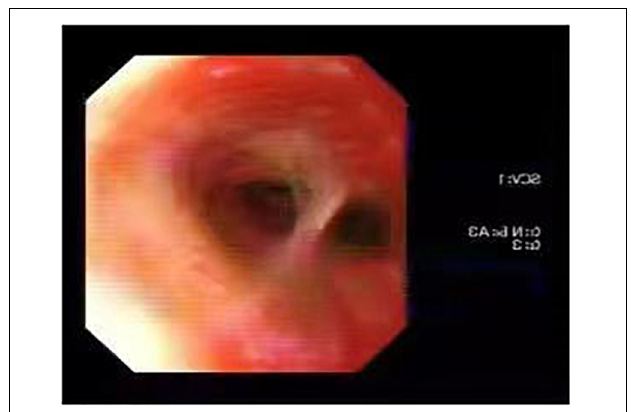
FIGURE 5 | Fiberoptic bronchoscopy showed bronchial total inversion, bronchial mucosal inflammation in both lungs.